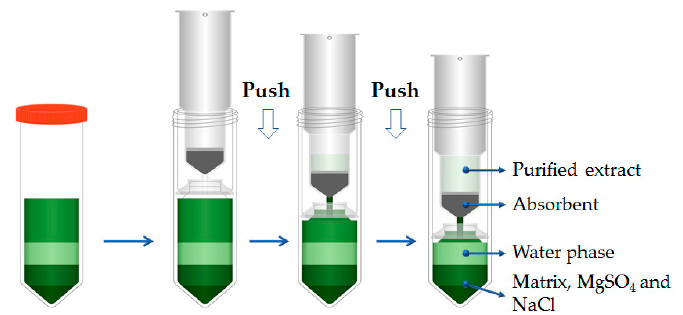
Figure 1. Schematic of the Sin-QuEChERS nano cleanup method.